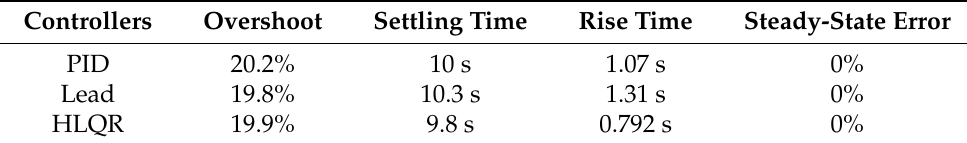
Table 7. The response of head system with